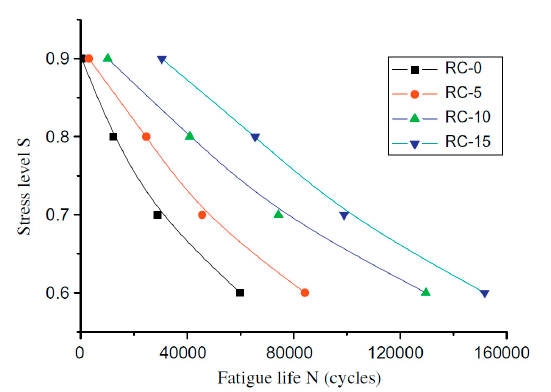
Figure 10. Relationship between fatigue life (N) and stress level (S) of rubberized concrete [53]. Reproduced with permission from F. Liu, W. Zheng, L. Li, W. Feng, and G. Ning, Mechanical and fatigue performance of rubber concrete; published by Elsevier, Construction and Building Materials, 2013.